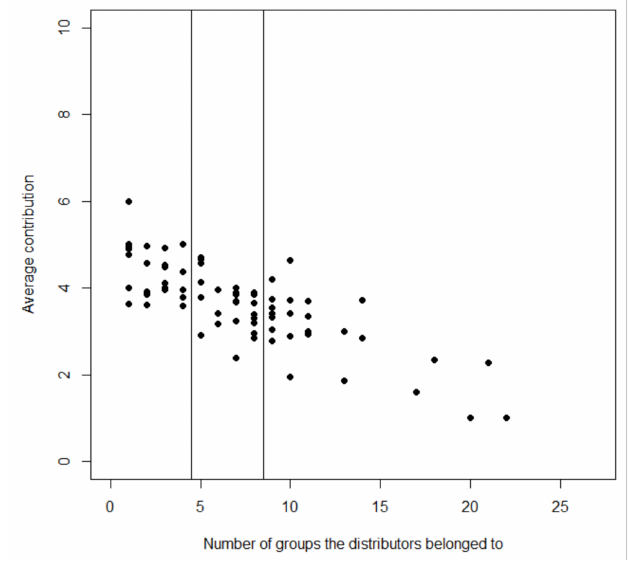
Figure 5. Average contribution of individual distributors, given the number of groups she belonged to. The vertical lines divide distributors into three sub-groups of roughly equal size: “few-group distributors”, i.e., distributors belonging to 4 groups or less (24 distributors), “multi-group distribu- tors” belonging to 9 groups or more (27 distributors), and “some-group distributors” belonging to a medium number of different groups (27 distributors).